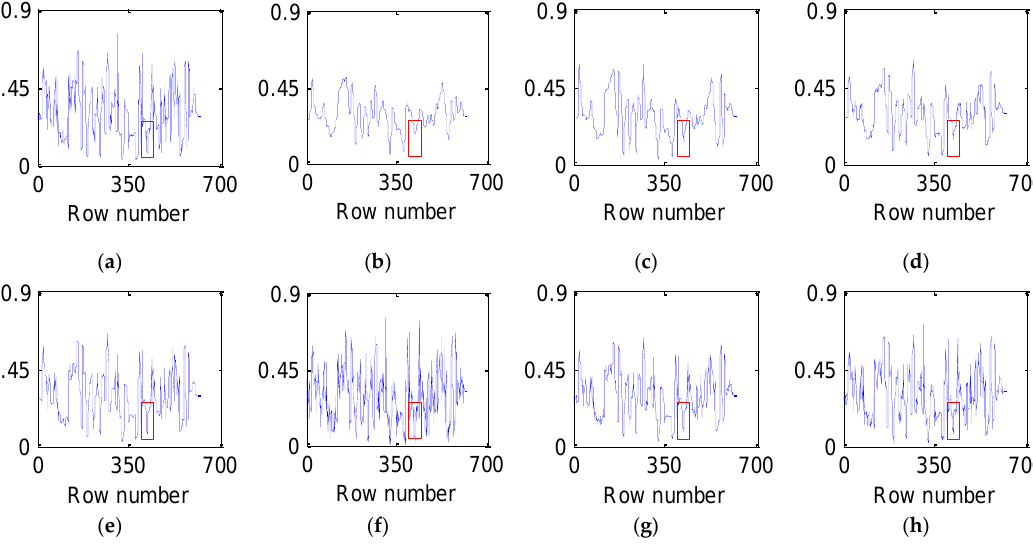
Figure 7. Vertical profiles of band 95 at pixel (559, 150) before and after denoising: ( a ) clean HSI; ( b ) KSVD; ( c ) BM3D; ( d ) ANLM3D; ( e ) BM4D; ( f ) LRMR; ( g ) DDL3+FT; ( h ) Our method.